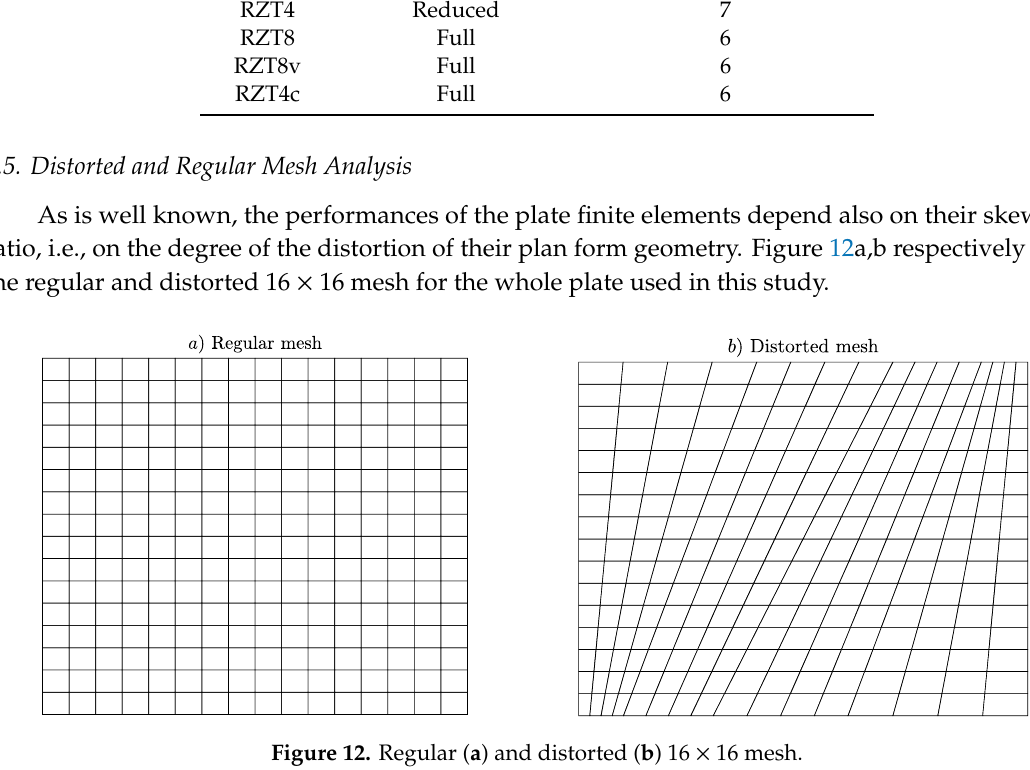
Figure 13. Load distributions for cantilever plates: ( a ) Uniform pressure (C1), ( b ) uniform pressure along the free edge (C2), ( c ) two opposite vertical forces (C3).